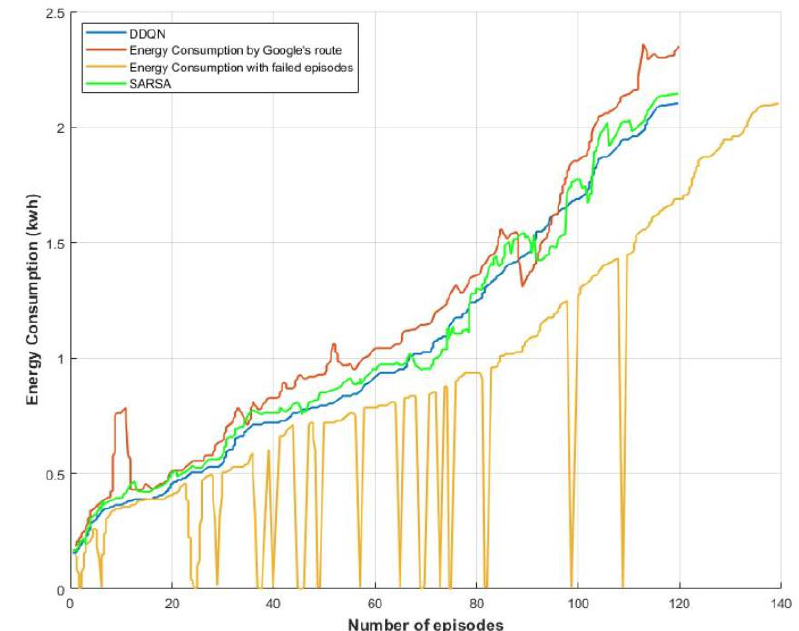
Figure 6. Benchmarking of the energy requirements of the first route for SARSA vs. DDQN and Google Maps.